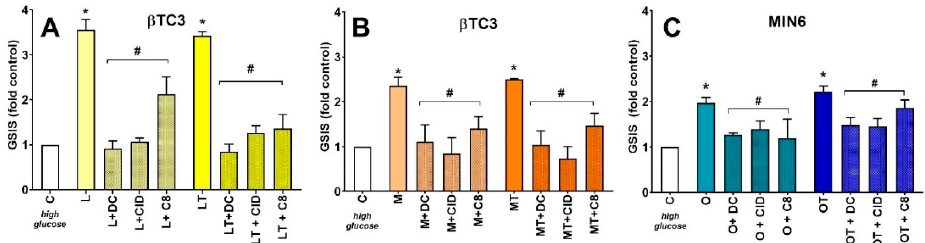
Figure 5. The G protein-coupled receptor (GPCR)-specific activity of most efficient GSIS potentiators in β TC3 ( A , B ) and MIN6 ( C ). GSIS experiments stimulated with native and modified LPCs are presented as fold control for 20 mM glucose conditions. DC, CID, and C8 correspond to antagonists of GPR40, GPR55, and GPR119, respectively. For the p -value less than 0.05 results are regarded as significantly different from control (high glucose) conditions ( C ) * or from the corresponding compound treatment after application of receptor antagonists # .